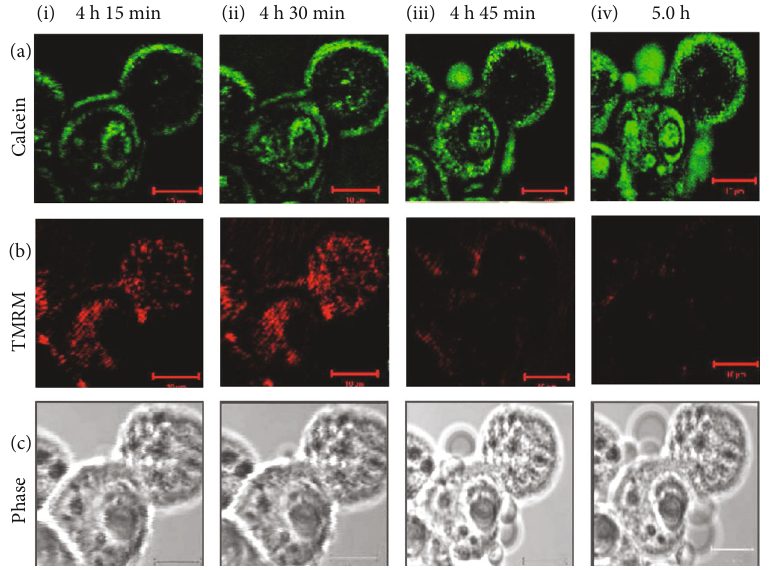
Figure 5: Onset of mitochondrial permeability transition (MPT) in isolated mouse hepatocytes due to arsenic exposure. Green fl uorescence of calcein (a), red fl uorescence of TMRM (b), and phase images (c) of the un fi xed hepatocytes were imaged simultaneously by confocal microscopy, and images were represented after 4h 15 min (i); 4 h 30min (ii); 4h 45 min (iii), and 5h (iv) of arsenic exposure. In the baseline images, green fl uorescence of calcein was limited to the cytosol and nucleus, whereas red fl uorescence of TMRM was observed in the mitochondria. Till 4 h 15 min of arsenic exposure, the baseline images remained unchanged (i). After 4 h and 30min of arsenic exposure, TMRM fl uorescence was increased (iib) indicating hyperpolarization of the mitochondria, whereas there was no signi fi cant change of green fl uorescence of calcein as shown in the image (iia). After 4 h and 45min, calcein began to redistribute from the cytosol into the mitochondria as evident by increase distribution of green fl uorescence, indicating onset of MPT (iiia) with simultaneous membrane blebbing as shown by the phase image (iiic), and mitochondria lost most of the TMRM red fl uorescence (iiib). After 5h, TMRM red fl uorescence almost disappeared rather weak, and one cell lost TMRM fl uorescence completely (ivb). Increase in cell membrane blebs was seen in the phase image (ivc) as well as calcein fl uorescence was almost uniformly distributed (iva) indicating the completion of MPT. Scale bar ( −− ) is 10 μ